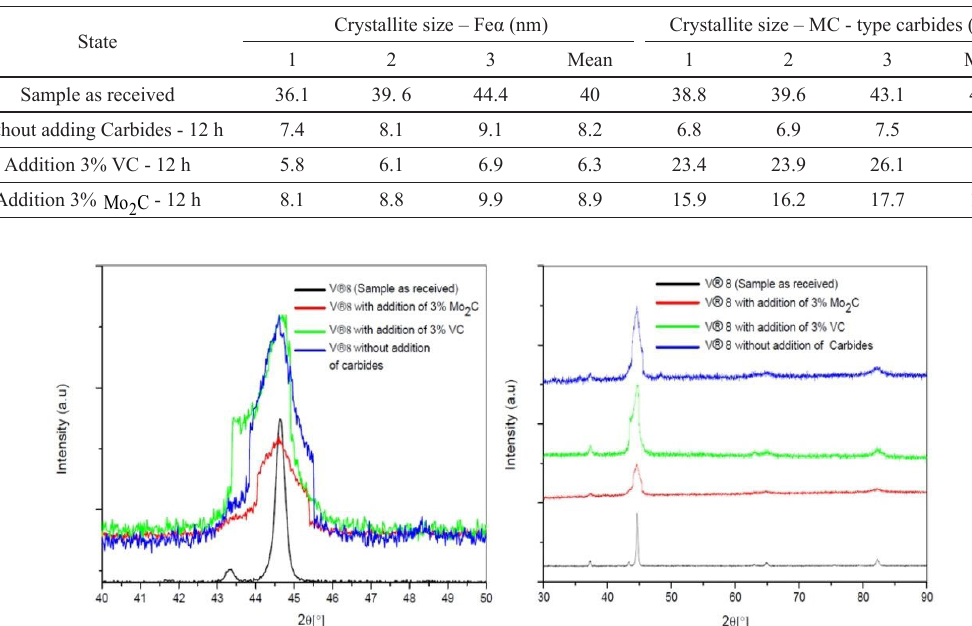
Figure 11: Diffractograms obtained from the Vanadis ® 8 chips milled for 12 hours under different conditions